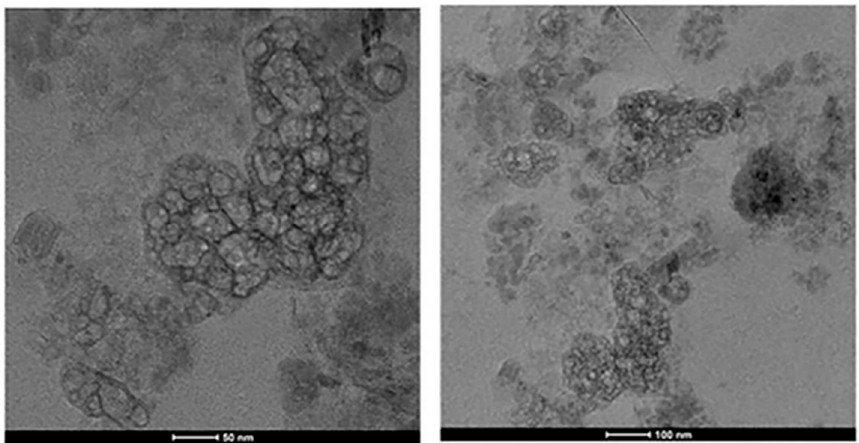
Figure 6. TEM Images of SPDPMA70 showing the presence of a phase separated domain structure, where the light coloured domains are from the PDPMA segments.